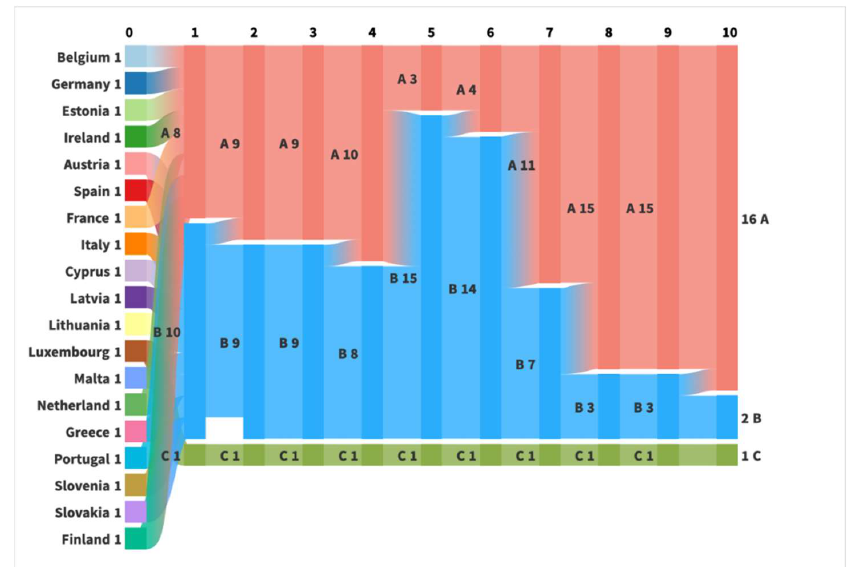
Figure 2. Sankey representation of cluster moves. Source Authors’ construction. Between 2010 and 2013 countries belonging to the first cluster (A) had a somewhat below average value for the first principal component , which means less financial assets in general, higher than average for the second component, that is higher volume of other deposits or, in other words, non-transferable deposits, and lower than average for the third principal component, currency. Countries belonging to this first group were Belgium, Germany, Estonia, Ireland, France, the Netherlands, Portugal and Finland. The second group (B), consisting of the rest of the countries (Greece, Spain, Italy, Cyprus, Latvia, Lithuania, Malta, Austria, Slovenia, Slovakia), had somewhat higher levels of financial assets in general than the first cluster (less negative relationship with the first component) but much higher currency-to-GDP levels and lower savings in insurance and technical reserves. Until 2014, only Austria and Latvia changed their positions, both moving to the first group from the second, Austria in 2011 and Latvia in 2013. In this period, the most representative (closest to the cluster centroid) country in the first group was Germany, while for the second it was Italy and Spain. In 2014, a lot of countries (Belgium, Germany, Estonia, Latvia, Austria, Portugal and Finland) moved to the second group, probably due to the effects of the sovereign debt crisis on portfolio decisions. The central country in this second group remained Spain in 2014. Some rearrangements occurred also in 2015 (the Netherlands and France went to group B, while Cyprus, Latvia, Slovakia moved to group A), but the number of countries belonging to the second group remained almost the same; there was a slight reduction from 15 countries to 14 countries. Nevertheless, the most spectacular change in 2015 was that the main features of group A and B were reversed, while group A became the country group with a relatively higher proportion in financial assets than the other group, higher-than average currency holdings but lower-than-average insurance reserves, in particular, whereas group B could be described with lower savings to GDP in currency, and higher insurance technical reserves